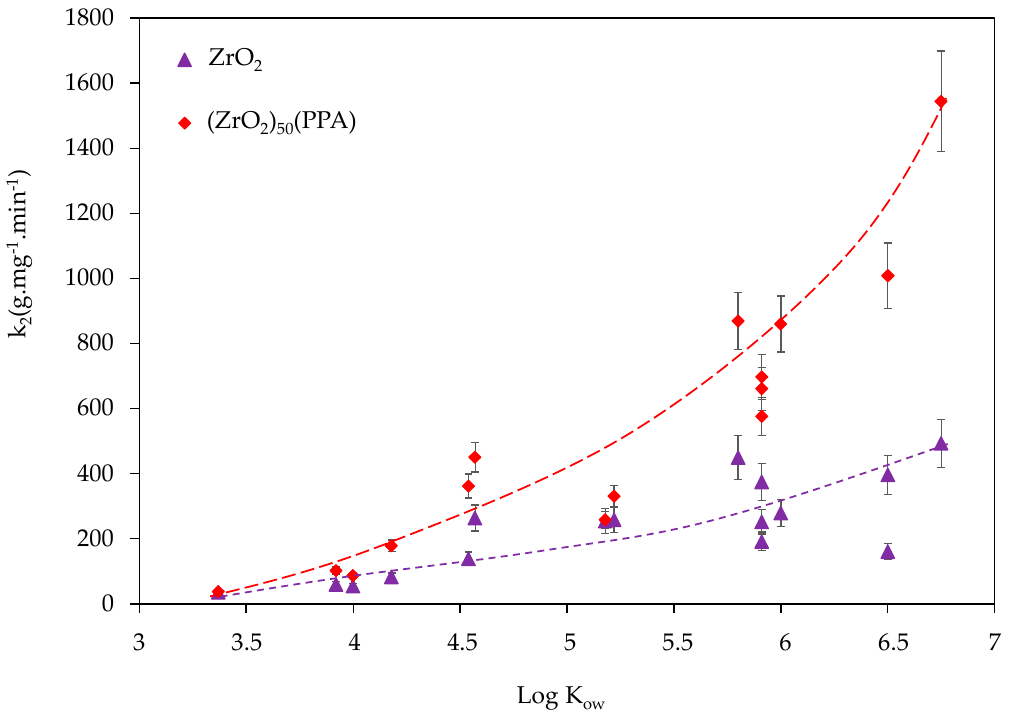
Figure 8. Variation of adsorption constant rate (k 2 ) as a function of octanol–water partition coefficient (Kow) for the 16 PAH molecules in the case of ZrO 2 or (ZrO 2 ) 50 (PPA).